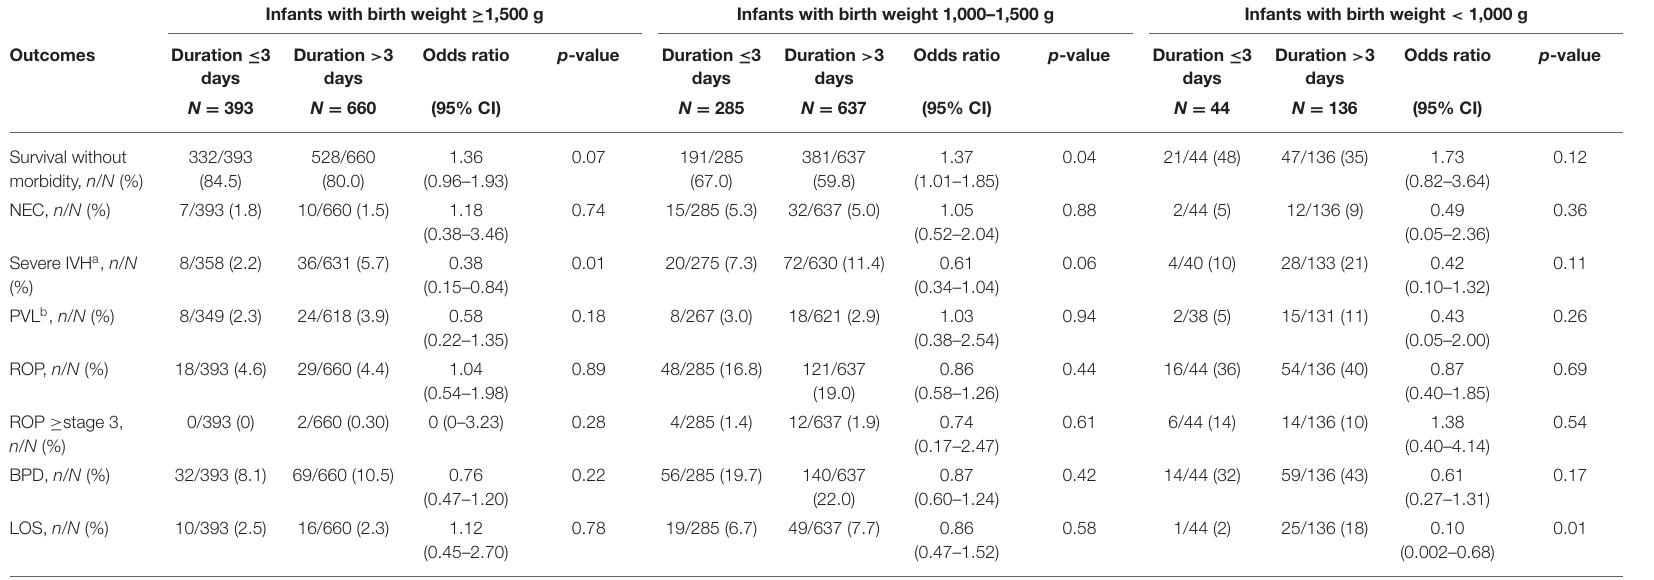
TABLE 4 | Outcomes and cardiovascular pharmacological support duration in different birth weight groups among